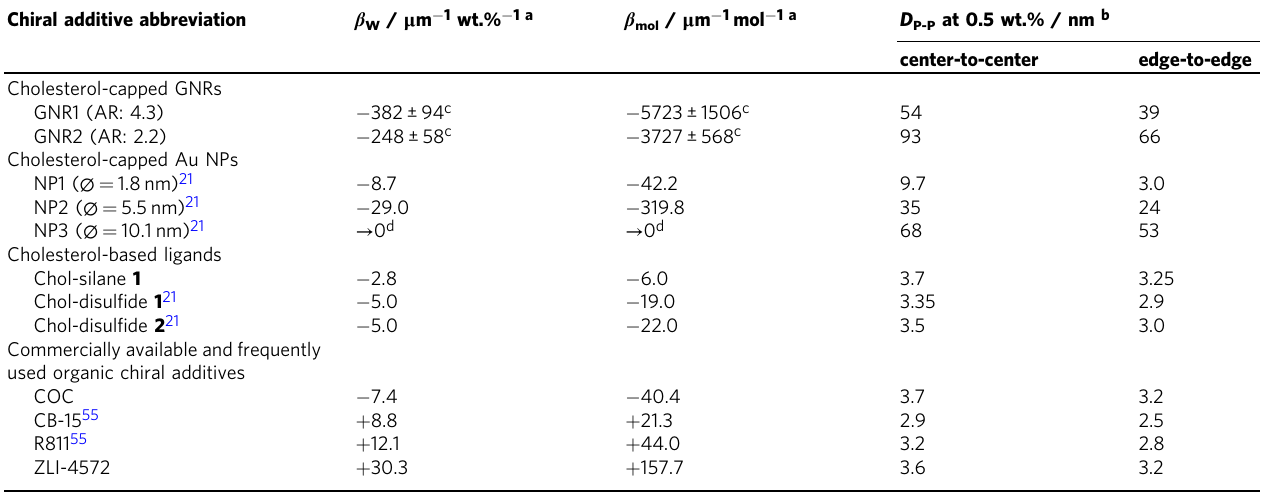
Table 1 Helical twisting power ( β W ), molar helical twisting power ( β mol ), and particle-particle distances ( D P-P ) for a given concentration of chiral additives in 5CB Chiral additive